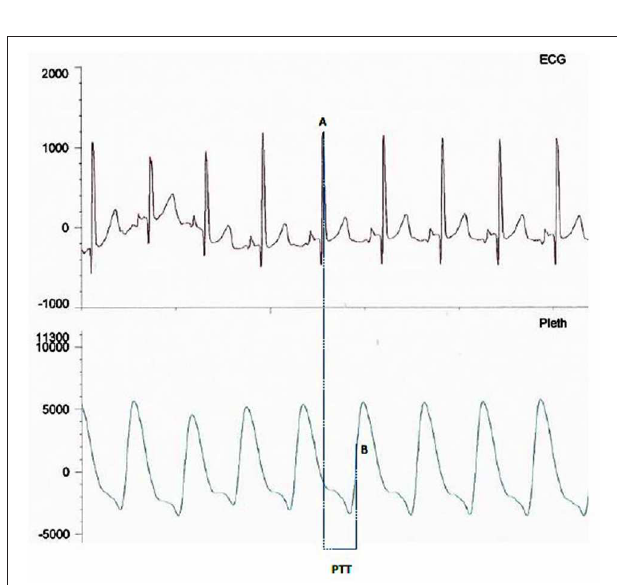
FIGURE 2 | Image showing PTT measurement between mid-point of the R wave (A) on the ECG trace and mid-point of the up slope (B) on the plethysmography